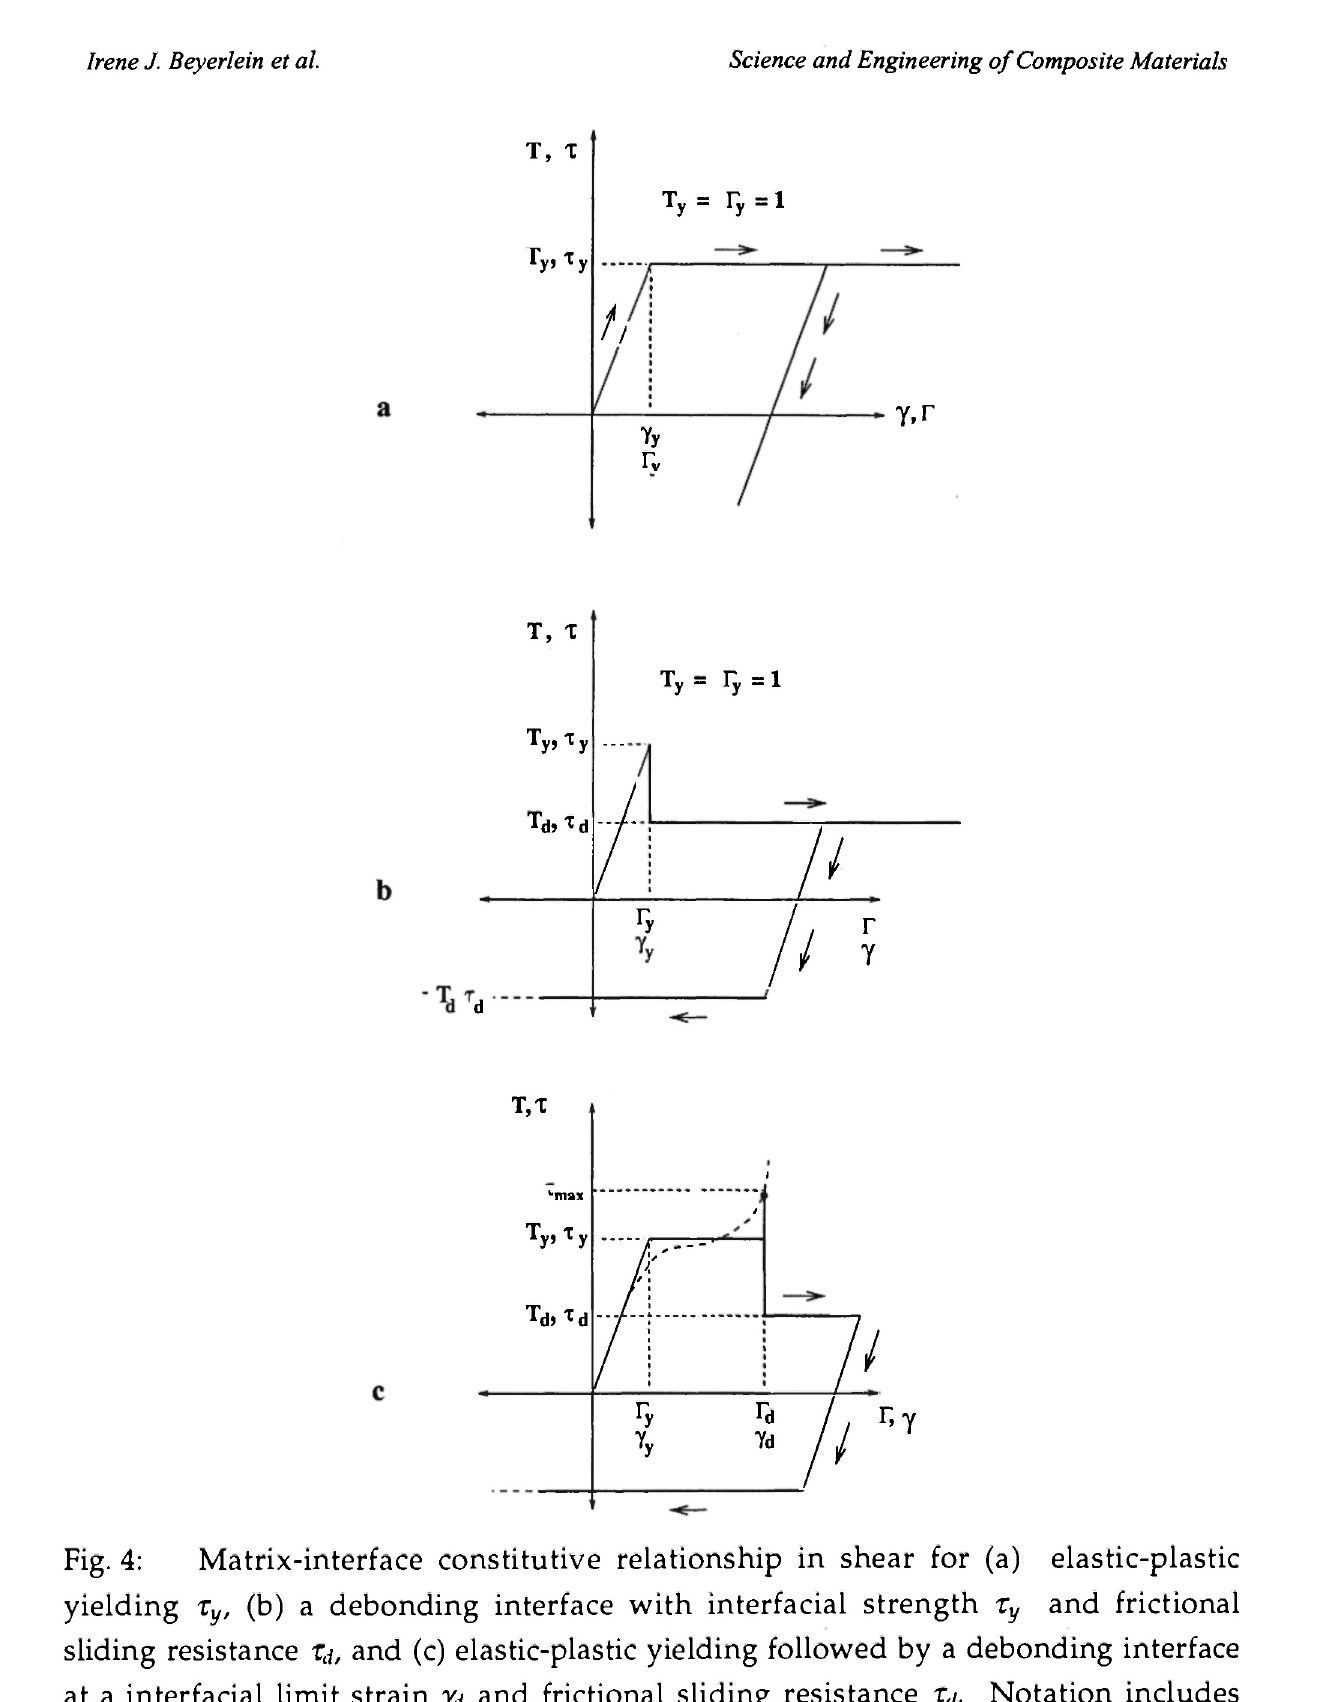
Fig. 4: Matrix-interface constitutive relationship in shear for (a) elastic-plastic yielding x , (b) a debonding interface with interfacial strength r y sliding resistance Xj, and (c) elastic-plastic yielding followed by a debonding interface at a interfacial limit strain % and frictional sliding resistance τ,ι- Notation includes both physical τ d, f ,7<λ 7y, and dimensionless quantities, Tj, T y